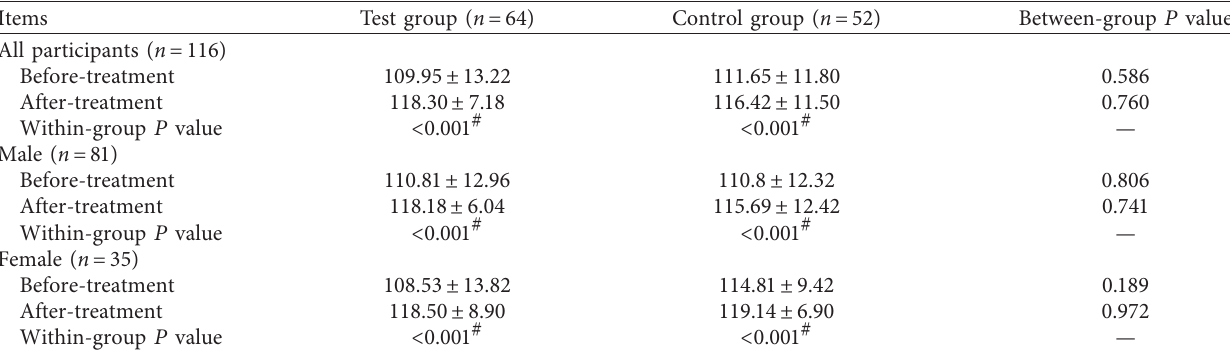
Table 5: Range of motion of the injured knee ( N � 116).